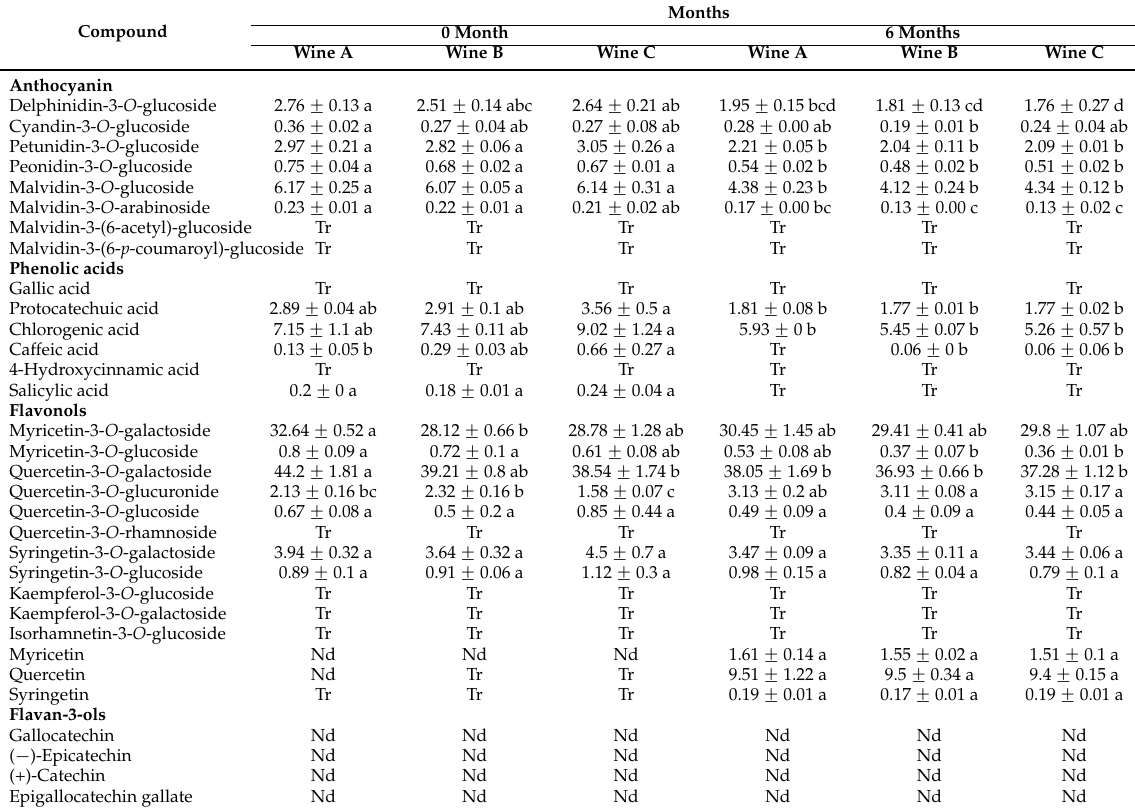
Table 2. The concentrations of polyphenolic compounds (mg/L) in bog bilberry syrup wines.